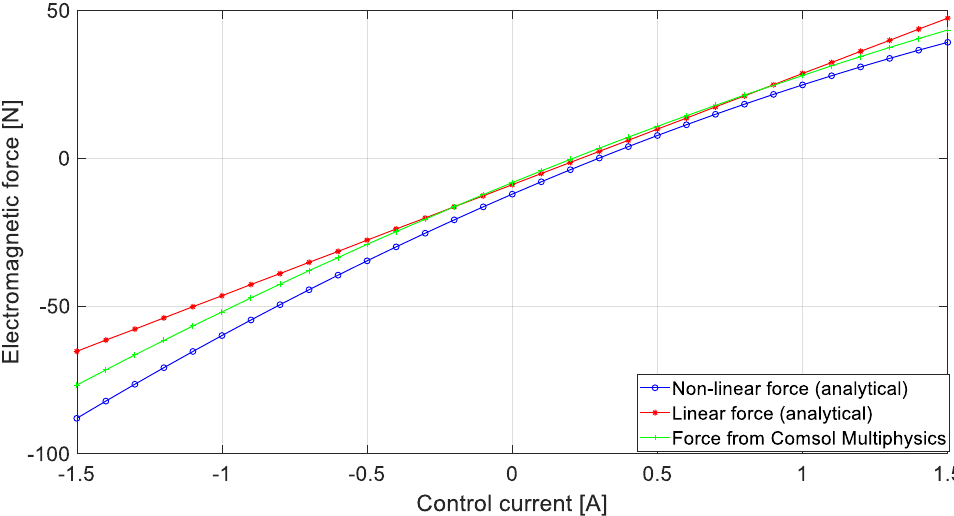
Figure 20. The resultant electromagnetic force generated by the magnetic bearing for different values of the control current for the rotor – shaft raceway displacement is equal to − 0.04 mm.